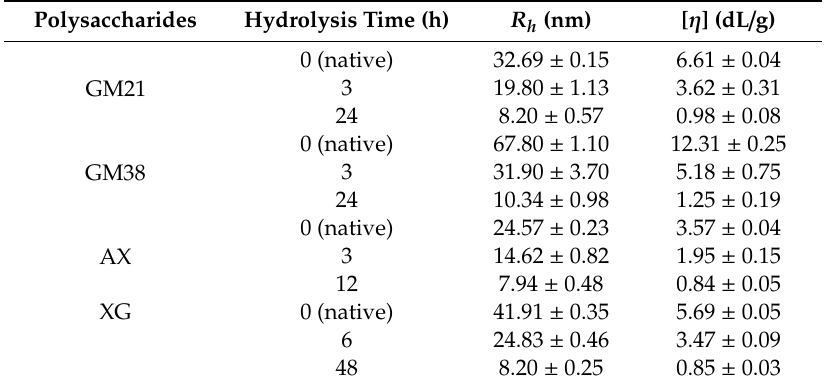
Table 1. Intrinsic viscosity and hydrodynamic radius evolution of GM21, GM38, AX, and XG before and after partial acidic hydrolysis.